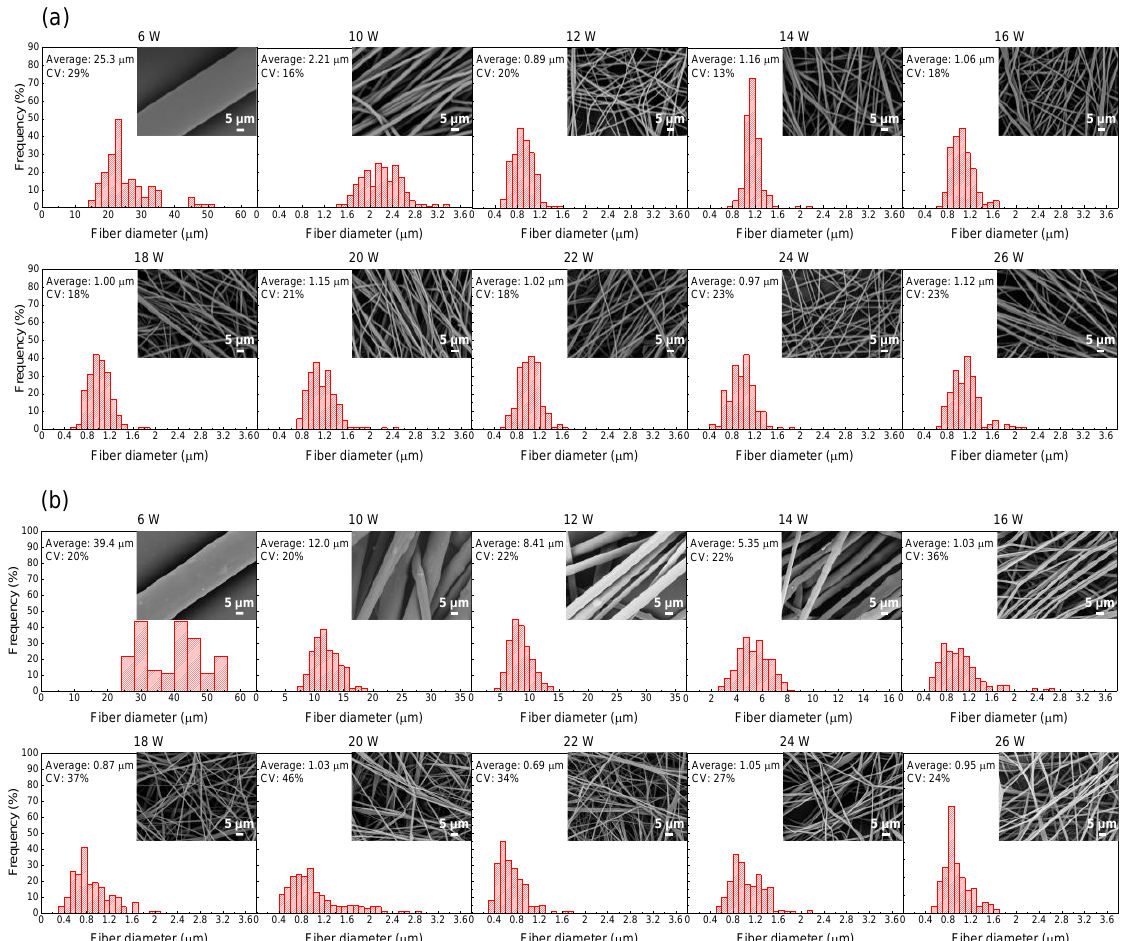
Figure 7. Diameter distributions: ( a ) PLLA and ( b ) BC/PLLA fibers in the electrospun webs fabricated at laser powers of 6–26 W.